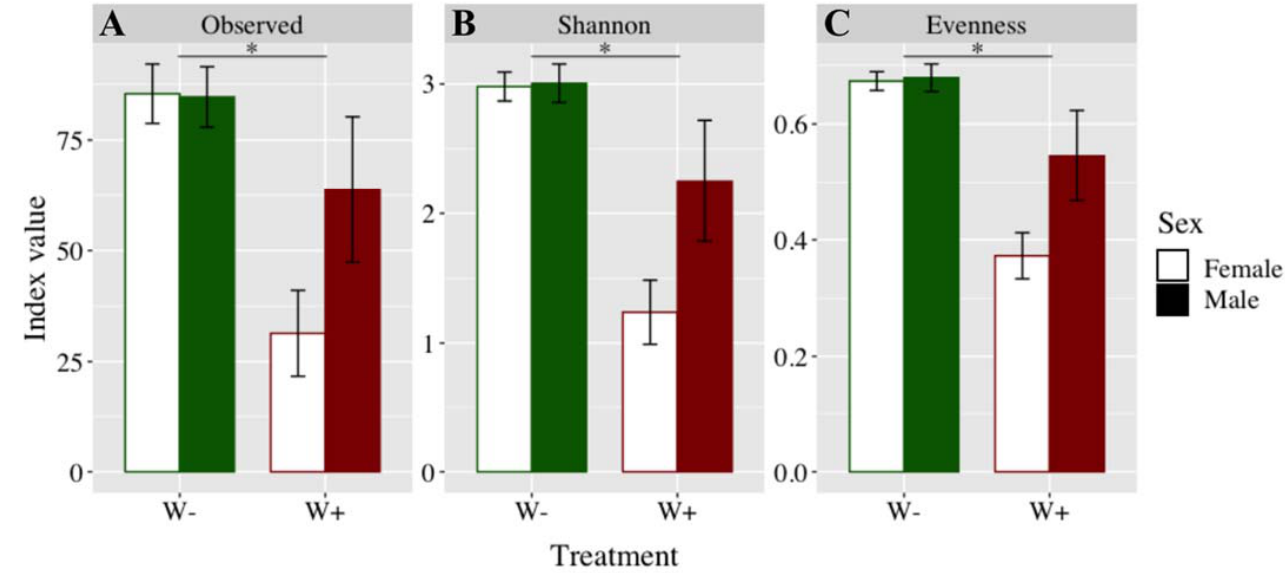
Figure 1. Bacterial alpha diversity of the Wolbachia -free (“W − ” in green) and infected (“W+” in red) lines. Mean values, standard errors, *: p < 0.001.